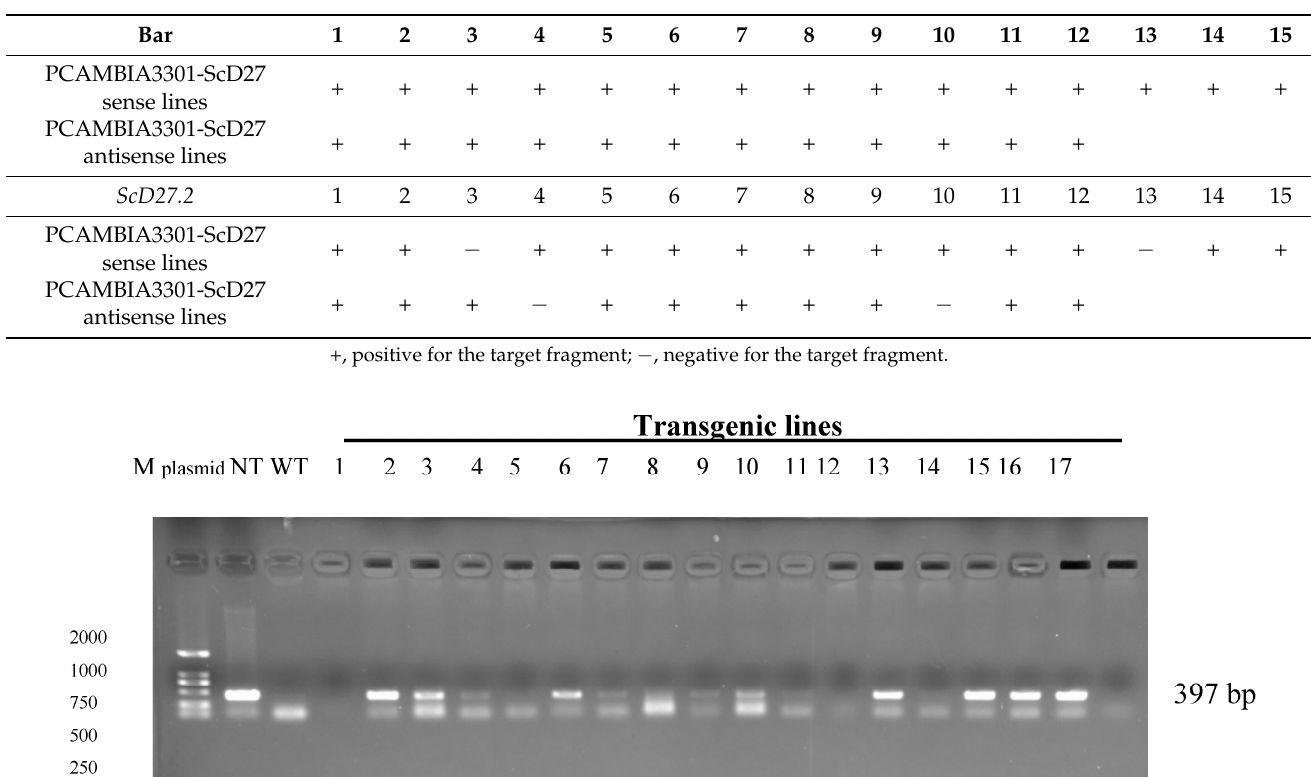
Table 1. Statistics for PCR detection of Bar and ScD27.2 genes in transformed lines.